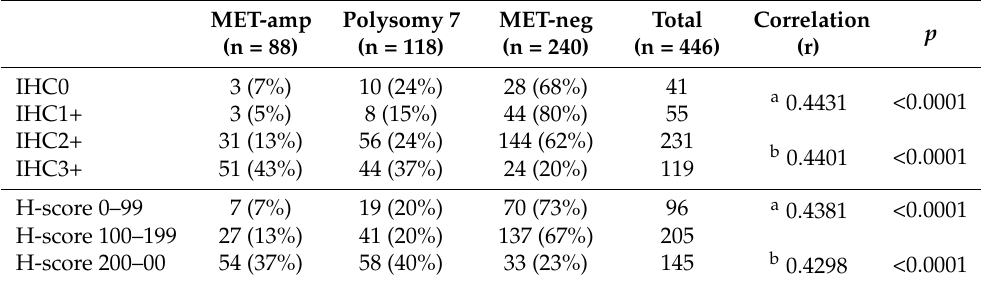
Table 2. Correlation of MET FISH groups with MET expression (IHC level or H-score).